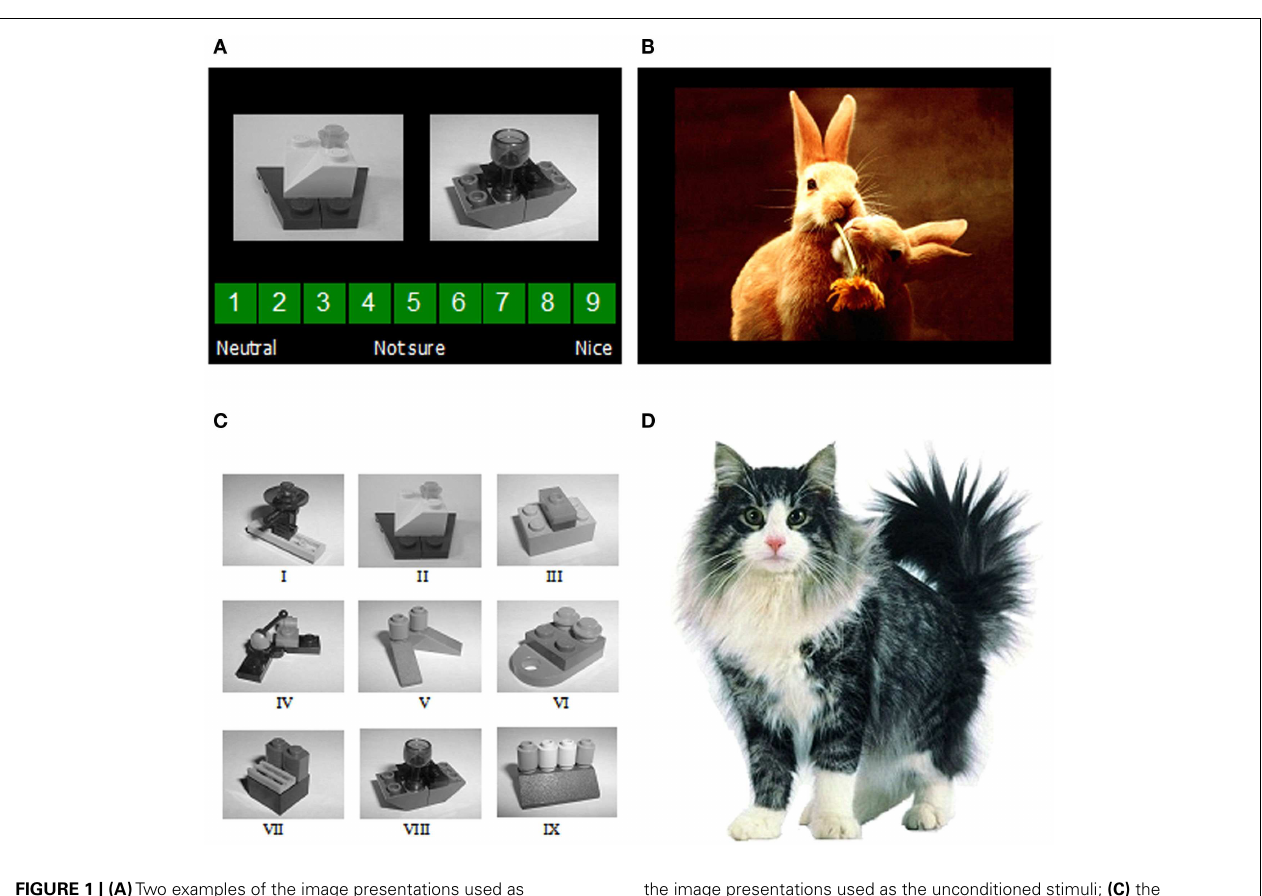
FIGURE 1 | (A) Two examples of the image presentations used as conditioned stimuli, shown together with the rating scale used to guess or predict what valence of unconditioned stimulus (a positive or neutral IAPS image) Mogwai would bring; (B) an example of one of